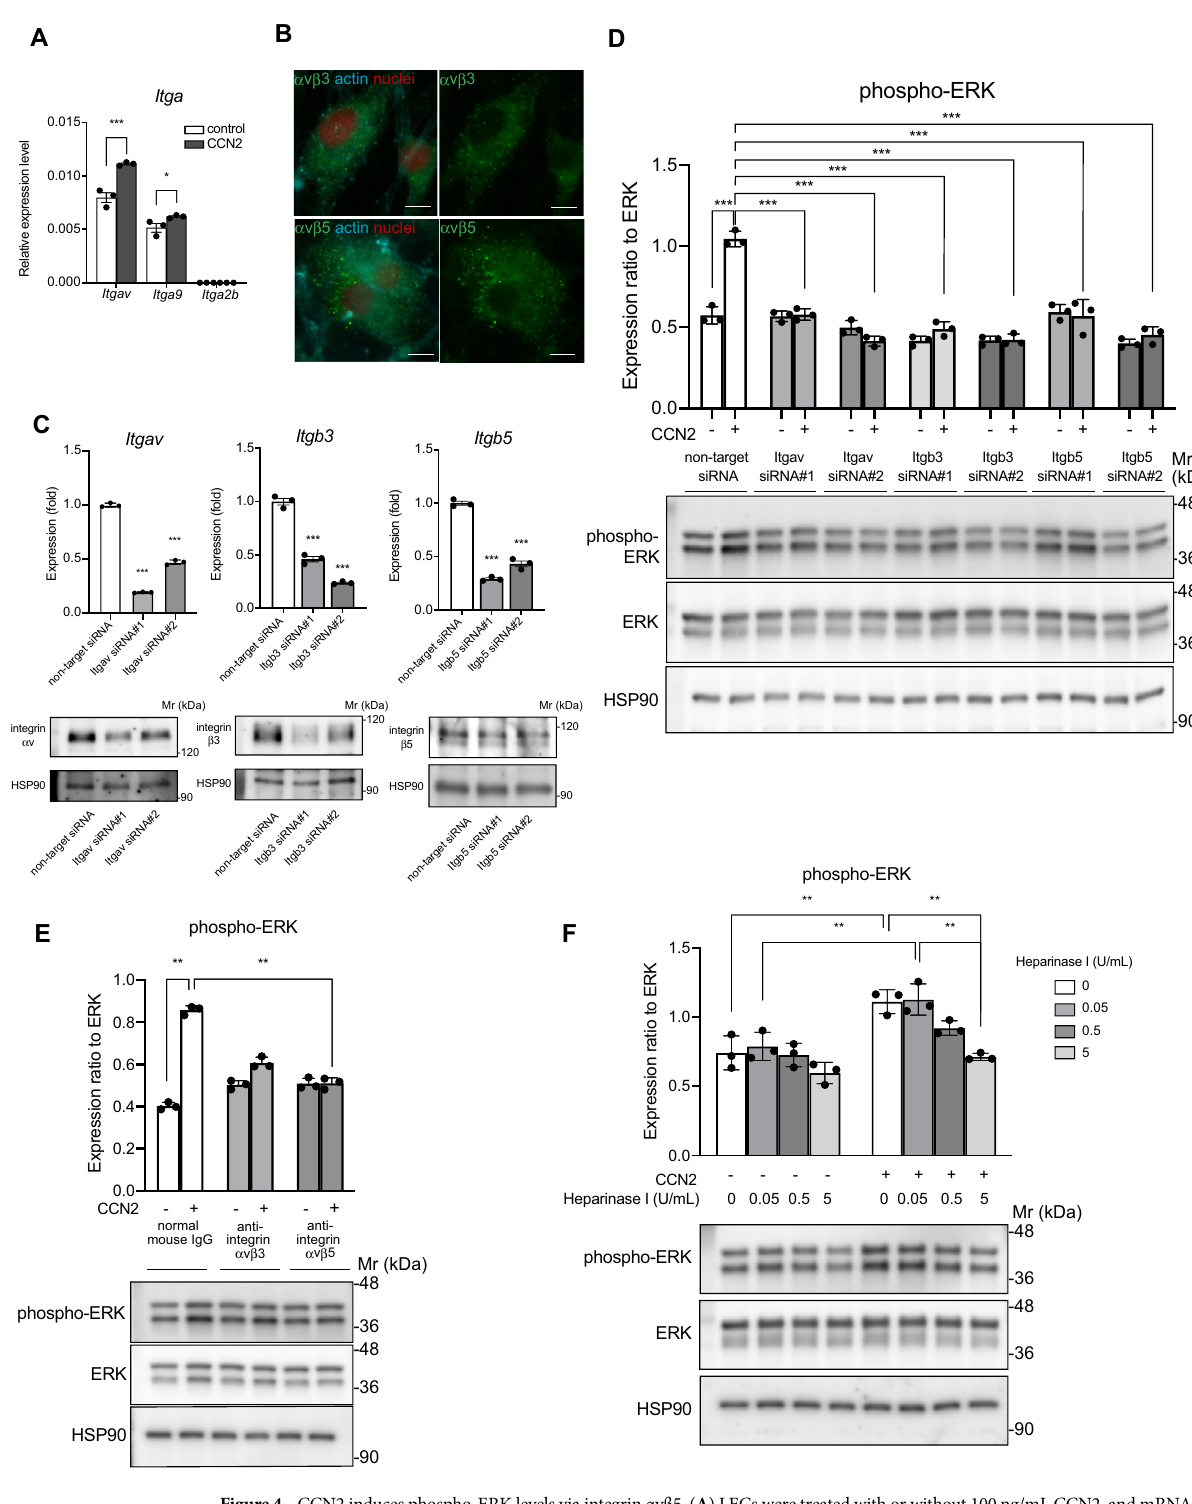
Figure 4. CCN2 induces phospho-ERK levels via integrin αvβ5. ( A ) LECs were treated with or without 100 ng/mL CCN2, and mRNA expression levels of Itgav, Itga9 , and Itga2b were evaluated by quantitative RT-PCR. Gene expression was normalized to levels of Actb mRNA. Two-way ANOVA, * p < 0.05, *** p < 0.001. ( B ) LECs were immunostained using anti-integrin αvβ3 or αvβ5 antibodies. Scale bars: 10 µm. ( C ) Suppression of integrins αv, β3 and β5 by siRNA. mRNA expression levels (upper) and protein levels (lower) in LECs transfected with non-target siRNA or integrins αv, β3 and β5 siRNA. One-way ANOVA, *** p < 0.001 versus non-target siRNA. ( D ) Western blot in LECs transfected with siRNA for Itgav, b3 and b5 and treated with CCN2. Phospho-ERK levels were quantified and normalized with total ERK expression levels, Two-way ANOVA, *** p < 0.001. ns; not significant. ( E ) The effects of integrin αvβ3 or αvβ5 neutralizing antibody on CCN2-induced ERK phosphorylation were examined by Western blotting, and the values of phospho-ERK were normalized by the expression level of total ERK. One-way ANOVA, ** p < 0.01 versus control LEC. ( F ) Phosphorylation of ERK in LECs pretreated with 0, 0.05, 0.5, or 5 U/mL heparinase I and stimulated with 100 ng/ml CCN2 for 10 min. Two-way ANOVA, ** p <